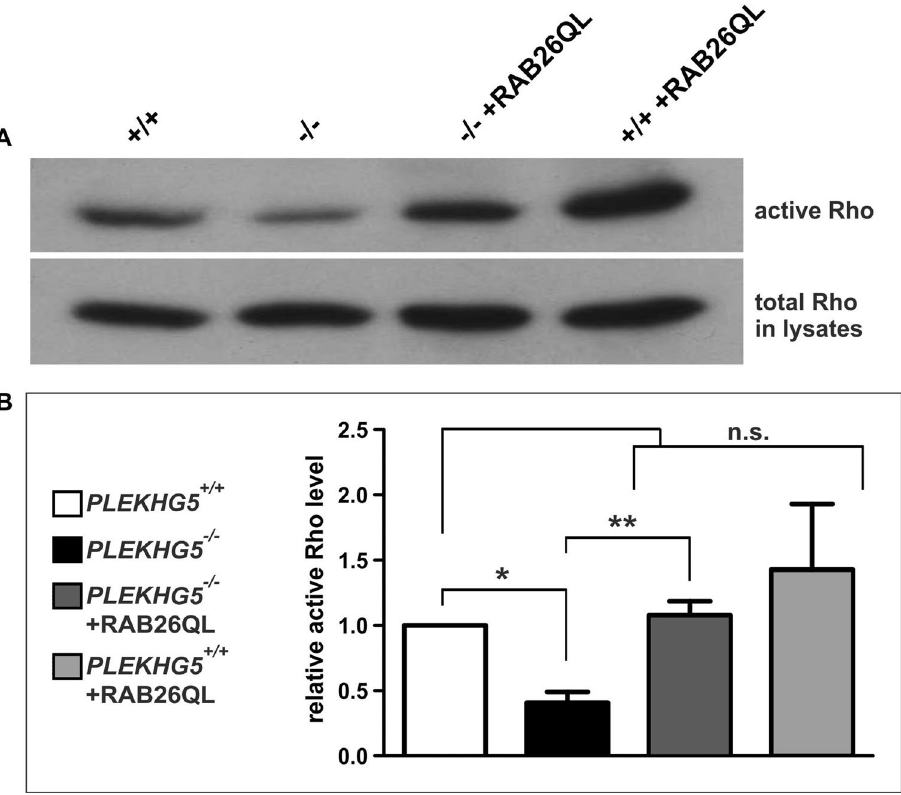
Figure 5. Rescue of PLEKHG5 knockout via RAB26 restored the depletion of RhoA activity in U251-MG. ( A ) Immunoblotting of fractionated U251-MG cell lysates depicted amounts of active RBD-bound RhoA and the quantity of the total RhoA protein after GST-RBD pulldown assay. ( B ) Quantification of Western blots showing the determined relative active RhoA levels normalised to the total RhoA protein amount in whole cell lysates. Significant reduction of active RhoA in PLEKHG5-deficient cells compared to U251-MG wildtype could be restored after phenotypic rescue in PLEKHG5 −/− + RAB26QL cells. No significantly changes could be examined between PLEKHG5 +/+ and PLEKHG5 −/− + RAB26QL or PLEKHG5 +/+ + RAB26QL cells. Statistical analysis were performed via paired, two-tailed t test, n = 3, ** p = 0.005 and * p = 0.020 were considered significant. Mean ±